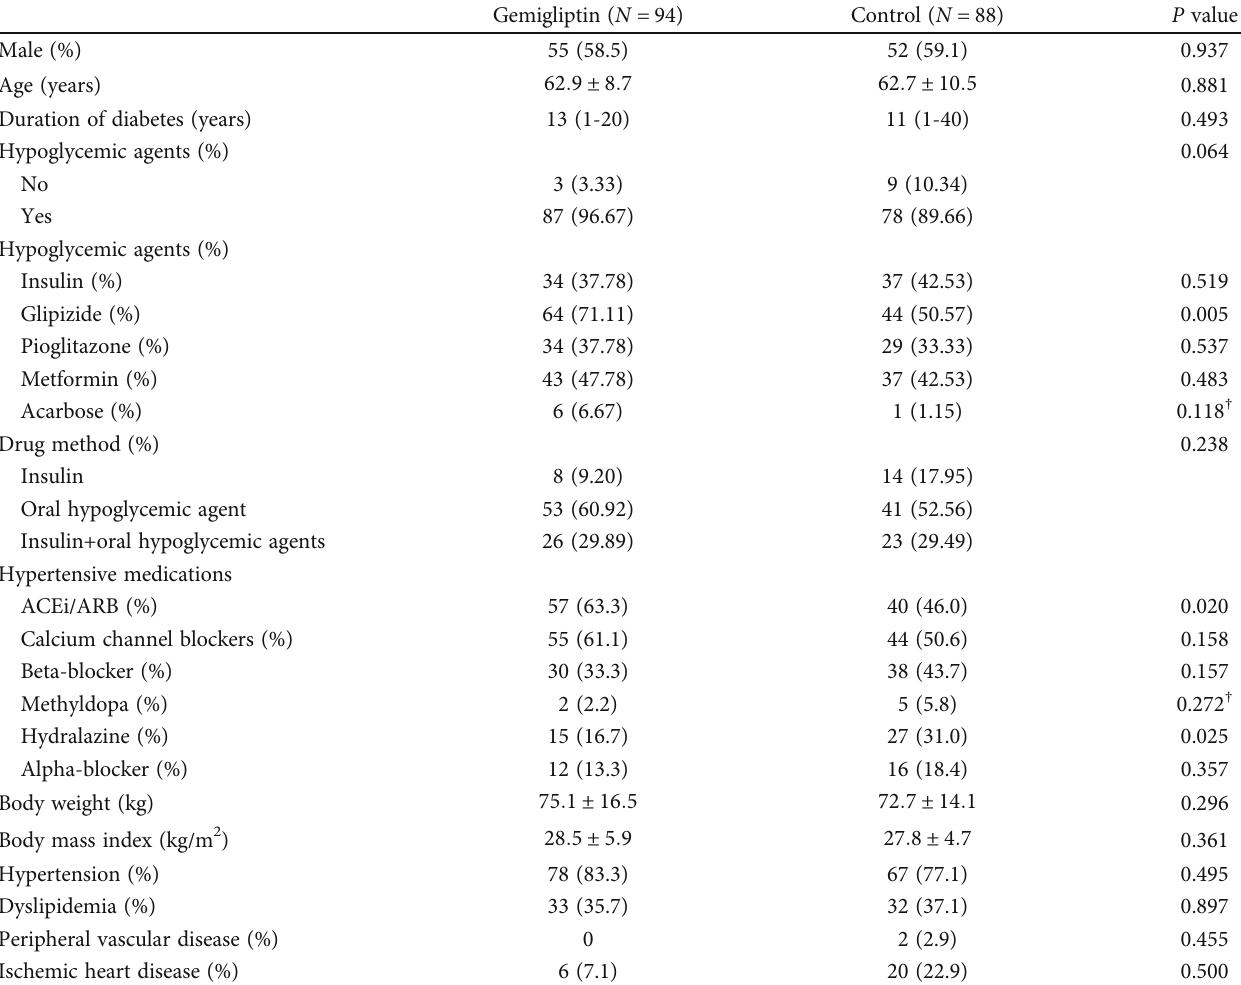
Table 1: Baseline characteristics of the two